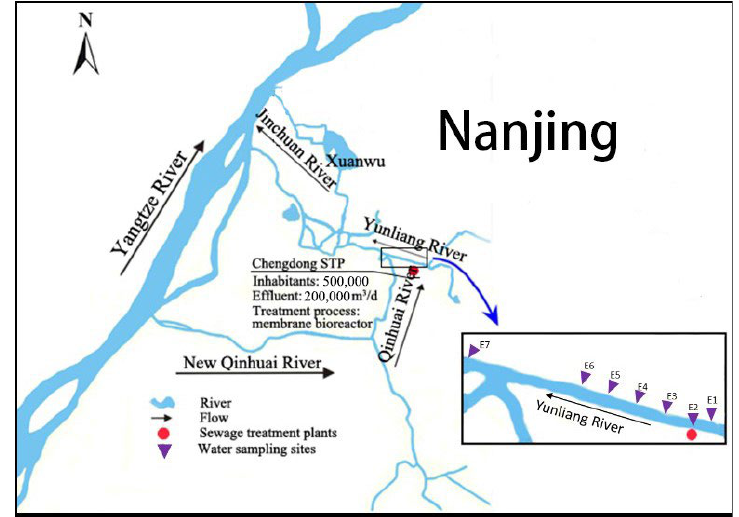
Figure 1. Sampling sites in the urban